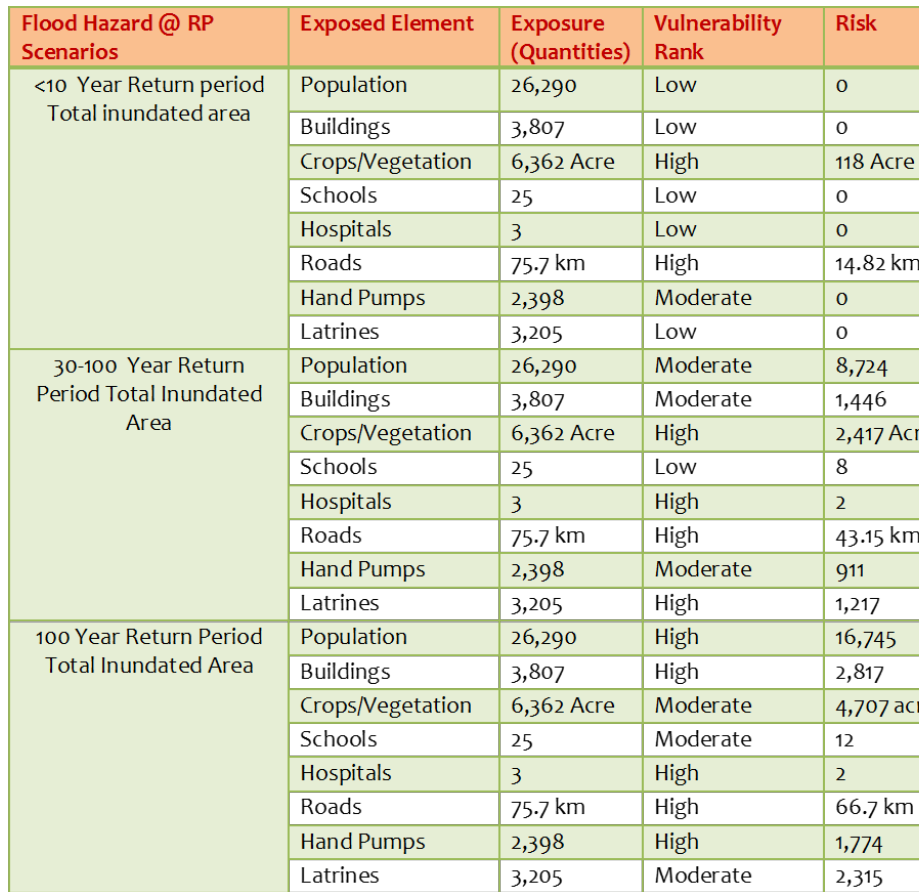
Table 3. Risk profile of UC Agra,